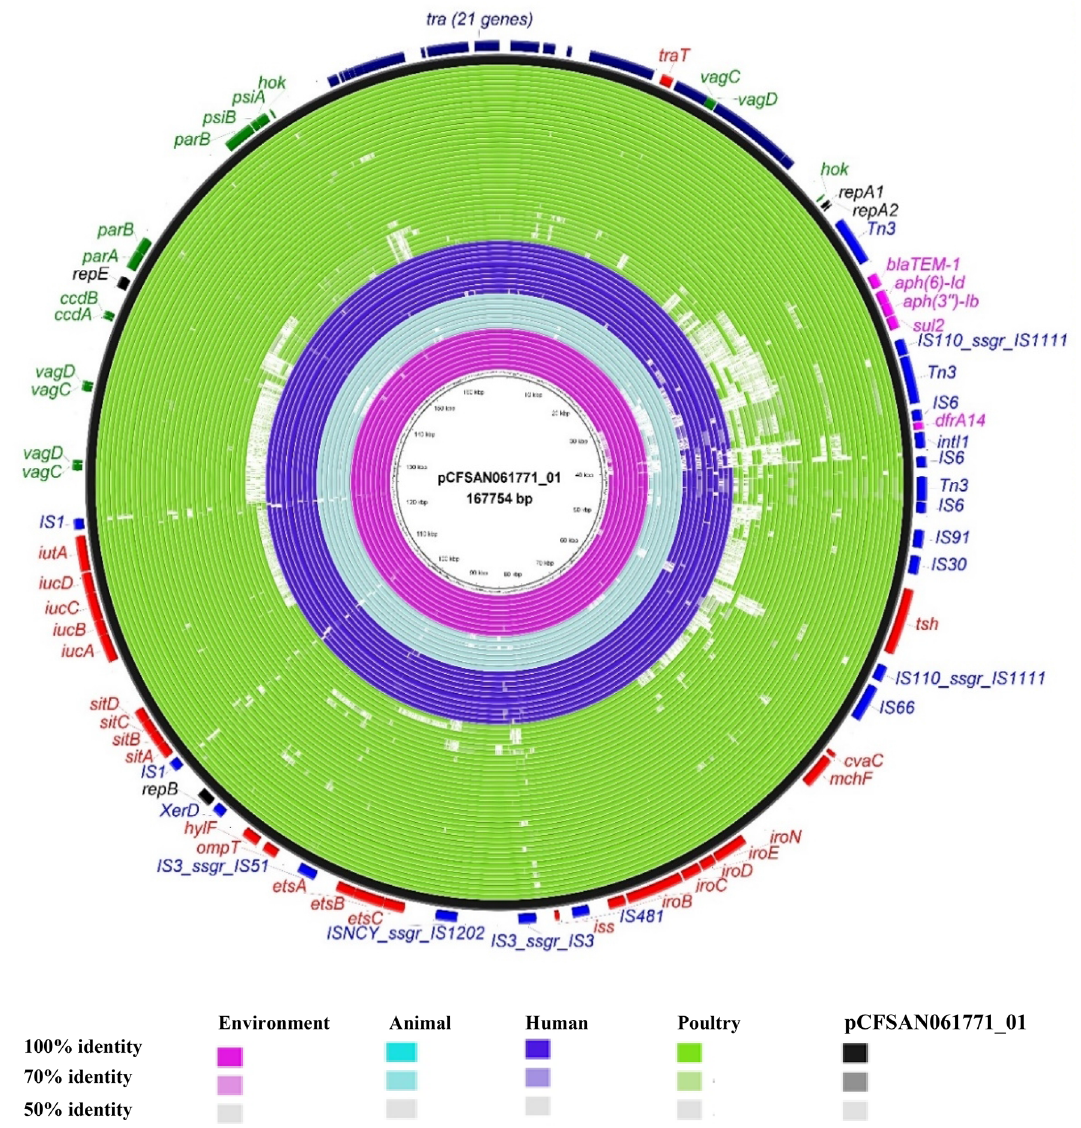
Figure 3. BRIG comparison of pCFSAN061771_01–like plasmids in Escherichia coli ST1485 strains. The pCFSAN061771_01 plasmid from the CFSAN061771 strain was used as reference for alignment and gene annotation and is shown in the outermost black circle. Query genomes are color-coded according to source and the order plotted in the circle reflects their similarities to pCFSAN061771_01. Gene inventories are colored as follows: red, virulence genes; fuchsia, antibiotic resistance genes; blue, insertion sequences; green (maintenance genes); black replication genes; navy, tra locus. Strains are arranged from inside as follow: